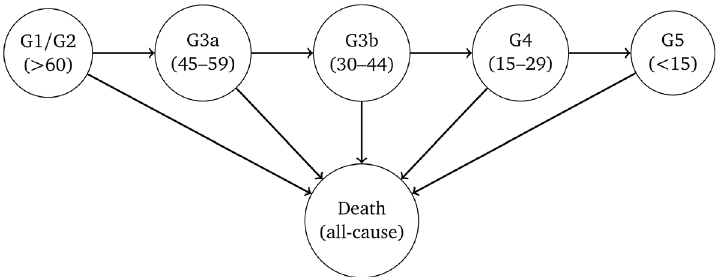
Figure 1. Representation of the model for the deterioration of kidney function over time. Arrows indicate permitted (instantaneous) transitions. The numbers in brackets depict the estimated glomerular filtration rate ranges (in ml/min/1.73 2 ) associated with each